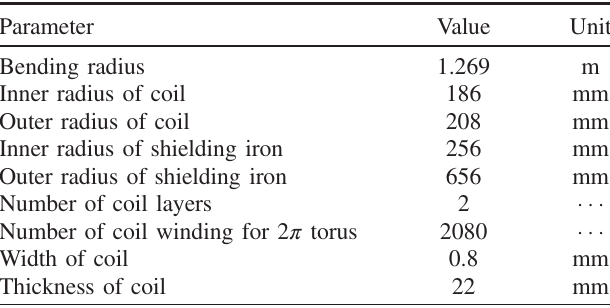
TABLE IV. Geometric parameters of the superconducting 90° combined-function magnet.